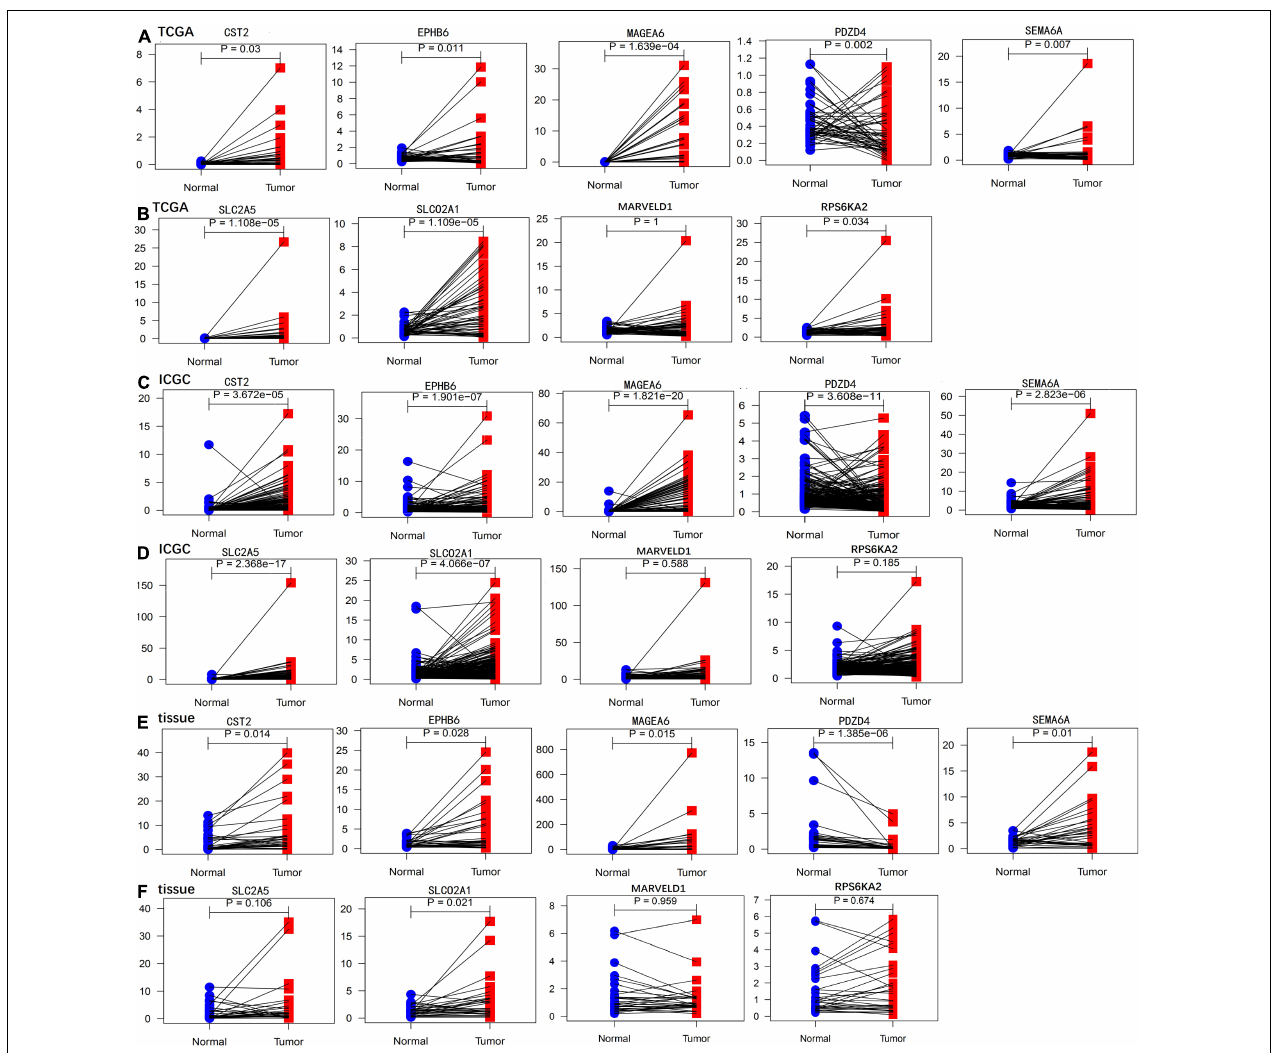
FIGURE 6 | Paired differential expression analysis of genes in the GIGSig. (A,B) Paired differential expression profiles of genes in the TCGA samples. (C,D) Paired differential expression profiles of genes in the ICGC samples. (E,F) Paired differential mRNA expression of genes in the HCC tissues from our